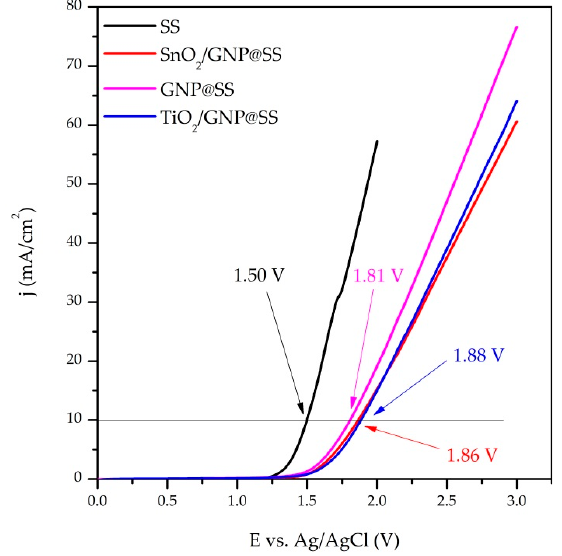
Figure 3. Linear sweep voltammograms of all investigated electrodes in 0.1 M Na 2 SO 4 at a scanning rate of 50 mV/s.